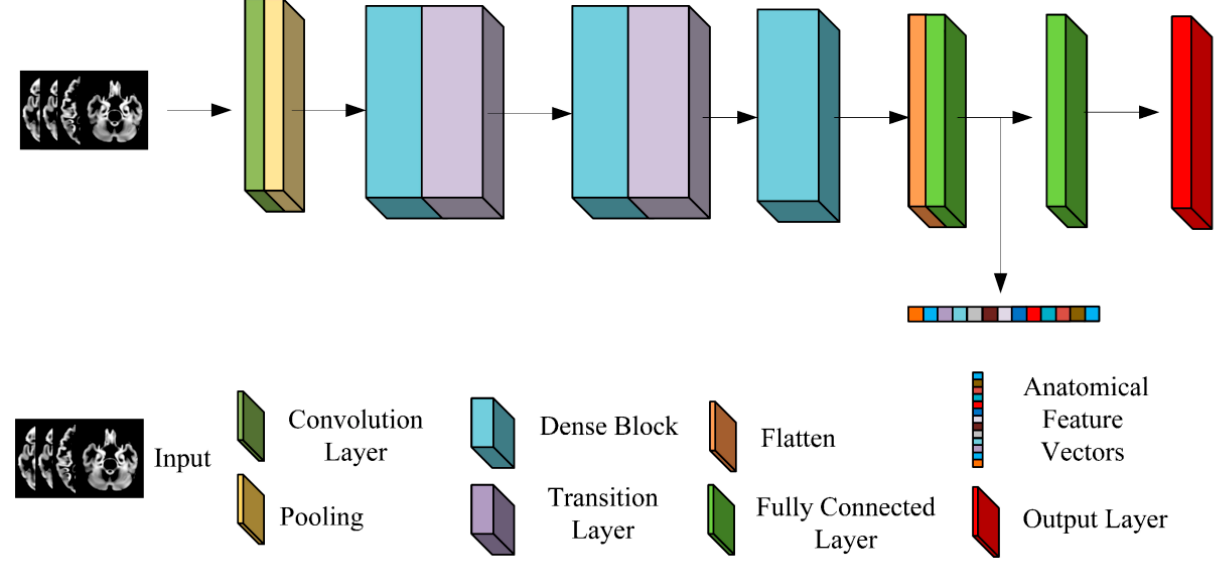
Figure 2. Illustration of the overall architecture of the 3D Densenet model.